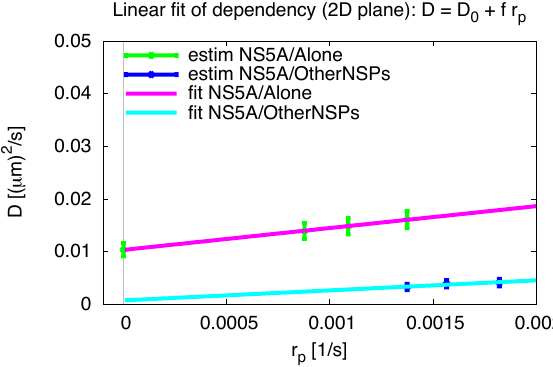
Figure A5. Dependency diffusion constant on pseudo reaction constant, linear fit of (A1) for 2D planar geometry. “estim”: estimated values, “fit”: linear fit.